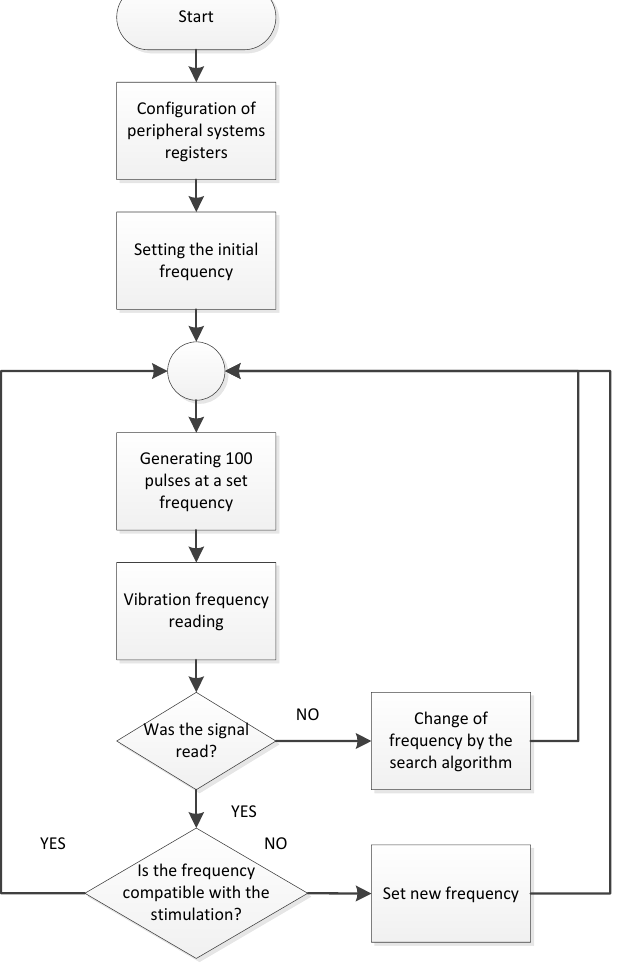
Figure 6. Wibrating wire strain gauge operating algorithm.